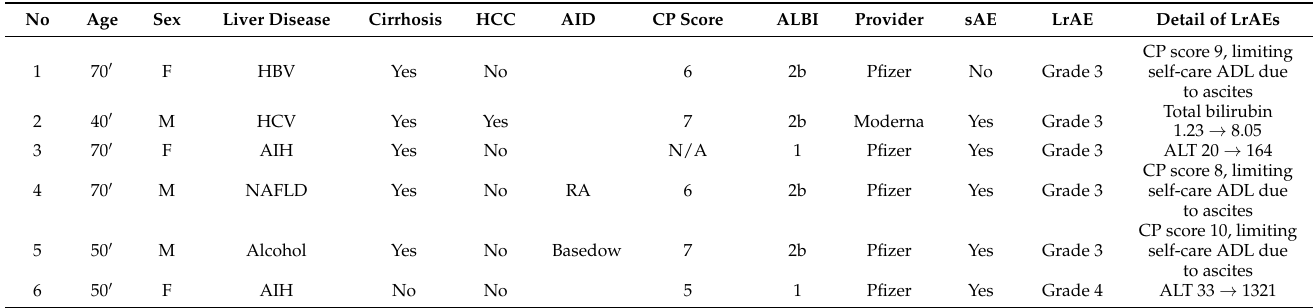
Table 3. Details of patients who had severe